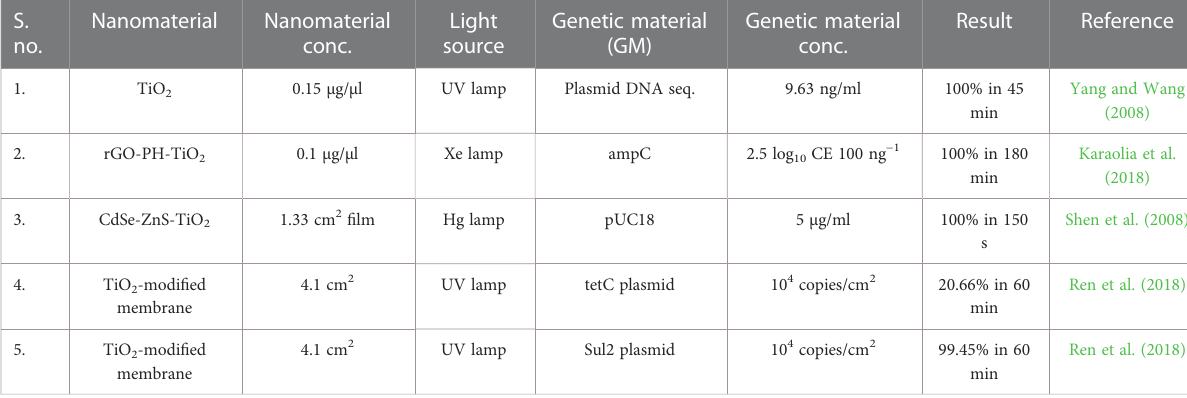
TABLE 4 Nanophotocatalytic degradation of genetic elements.